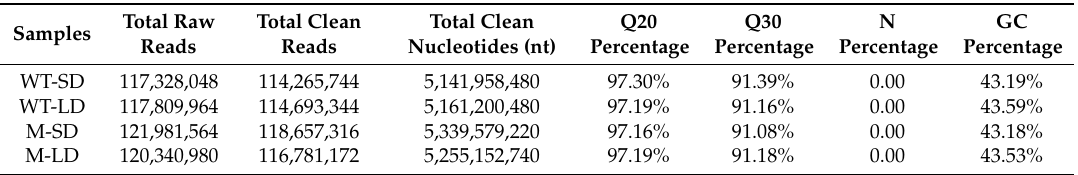
Table 1. Summary statistics of the RNA-Seq data.